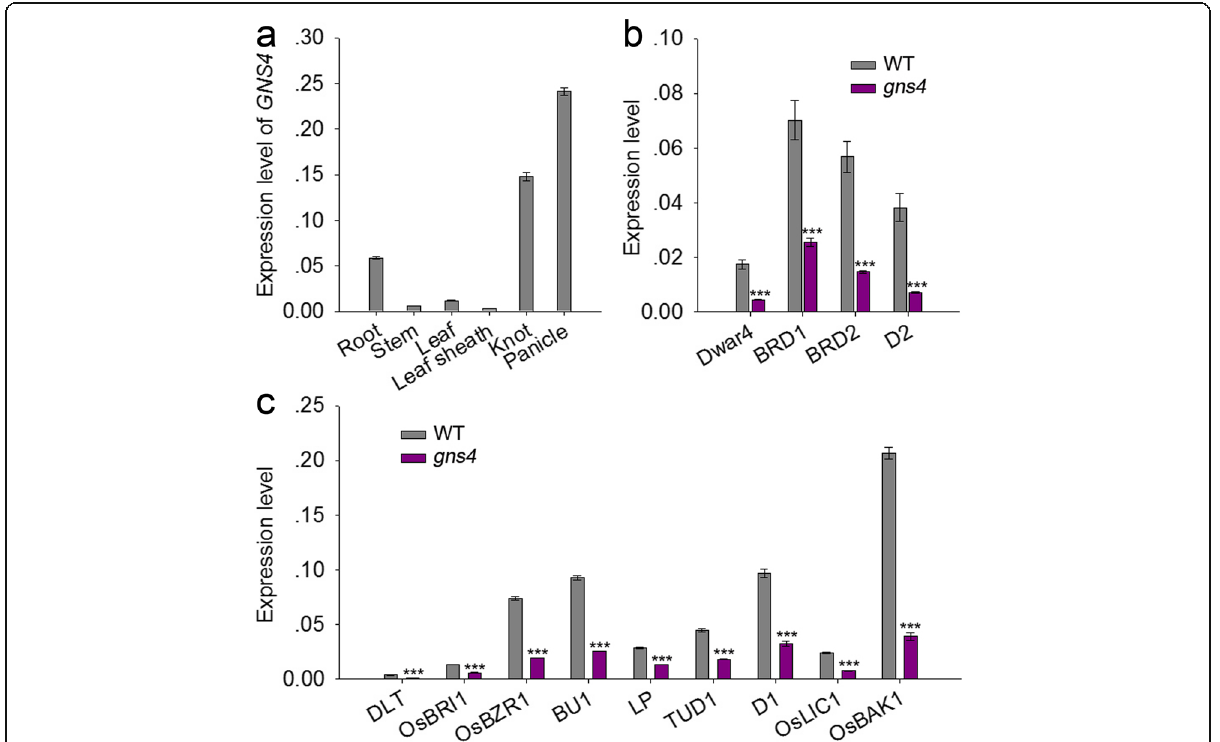
Fig. 6 Expression analysis of GNS4 by qRT-PCR. a Relative expression levels of GNS4 in different tissues. b Comparison of transcription level of genes involved in rice BR biosynthesis between WT and gns4 mutant. c Relative transcription levels of the genes related to BR signaling in WT and gns4 mutant. The expression level of the rice Actin gene was amplified as a control. Values are means ± s.e. of four independent